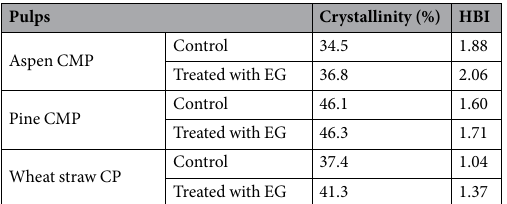
Table 5. HBI and crystallinity of different pulps before and after enzymatic